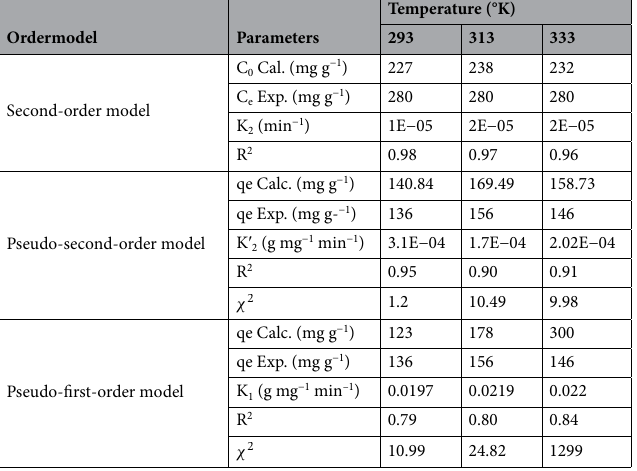
Table 8. Kinetic variables of Cu (II) ions adsorption on GFLE at 293, 313 and 333 o K.